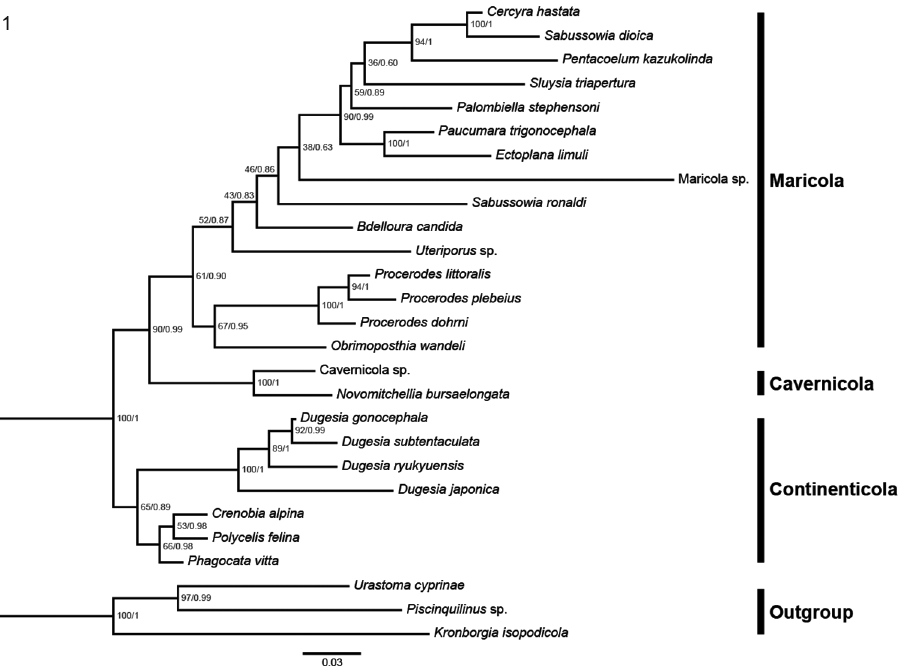
Figure 1. Maximum-likelihood tree based on 18S ribosomal DNA sequences. Numbers on nodes rep- resent support values for Maximum-Likelihood (bootstrap –BO) and Bayesian Inference (posterior prob- ability – PP): BO/PP. Scale bar indicates number of nucleotide substitutions per